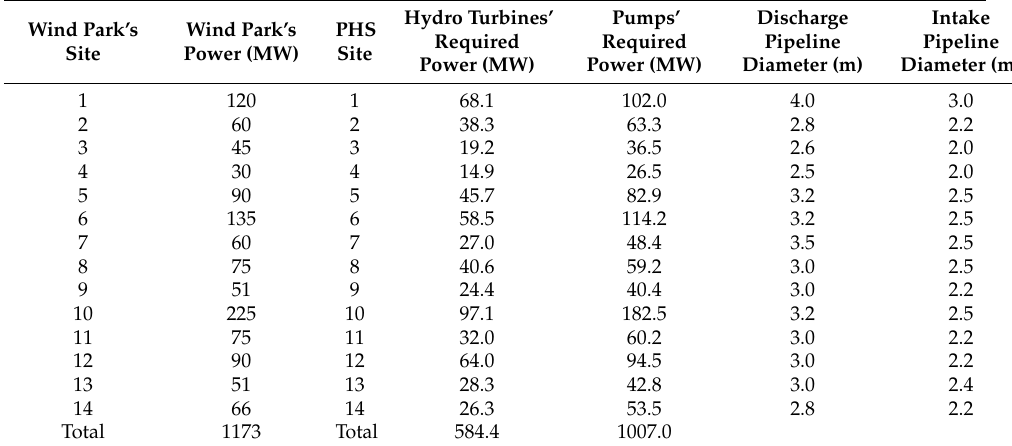
Table 11. Essential features of the selected sites for the installation of the PHS plants.